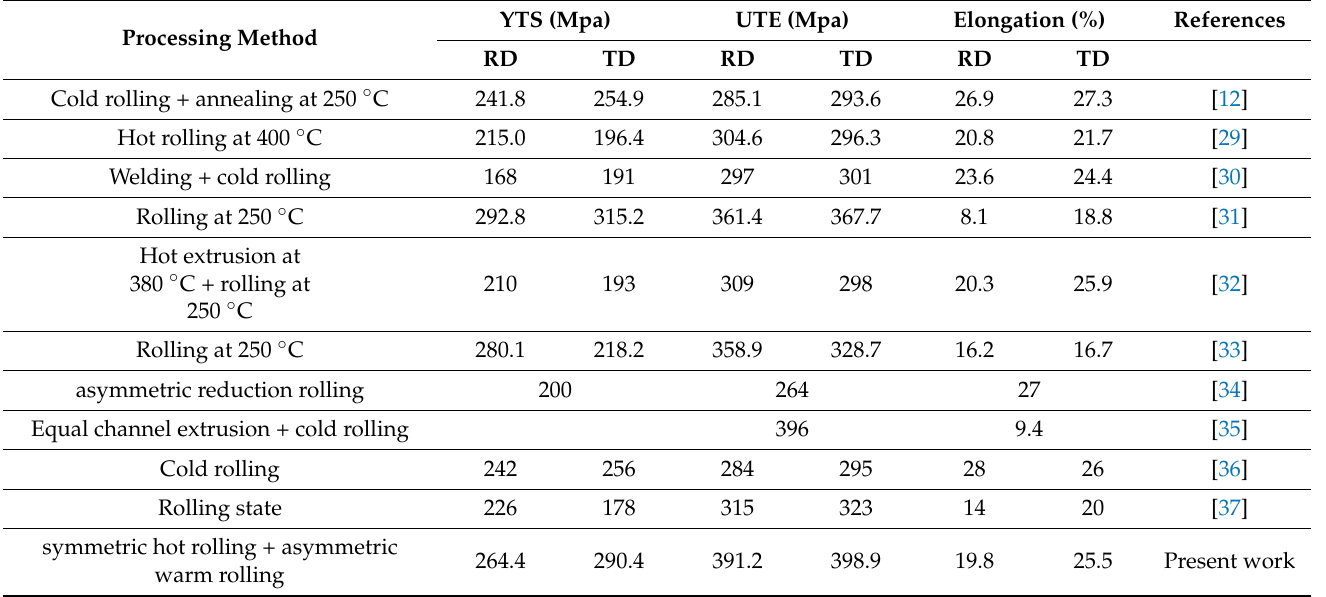
Table 4. Comparison of room-temperature properties of ZK60/ZK61 alloy under different processes.